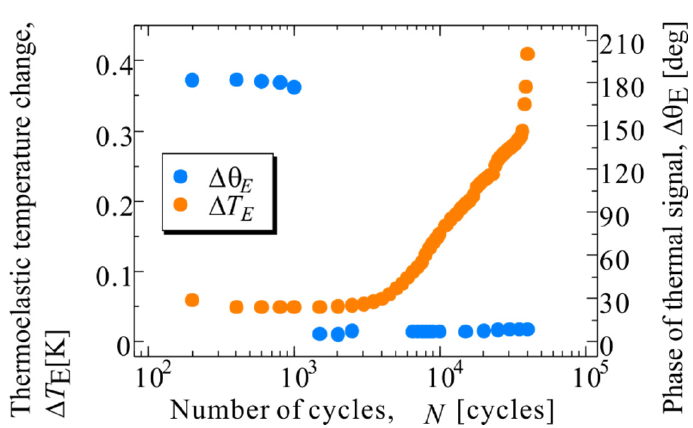
Figure 4. Change in the thermoelastic temperature change and phase of thermal signal in Area a-1.